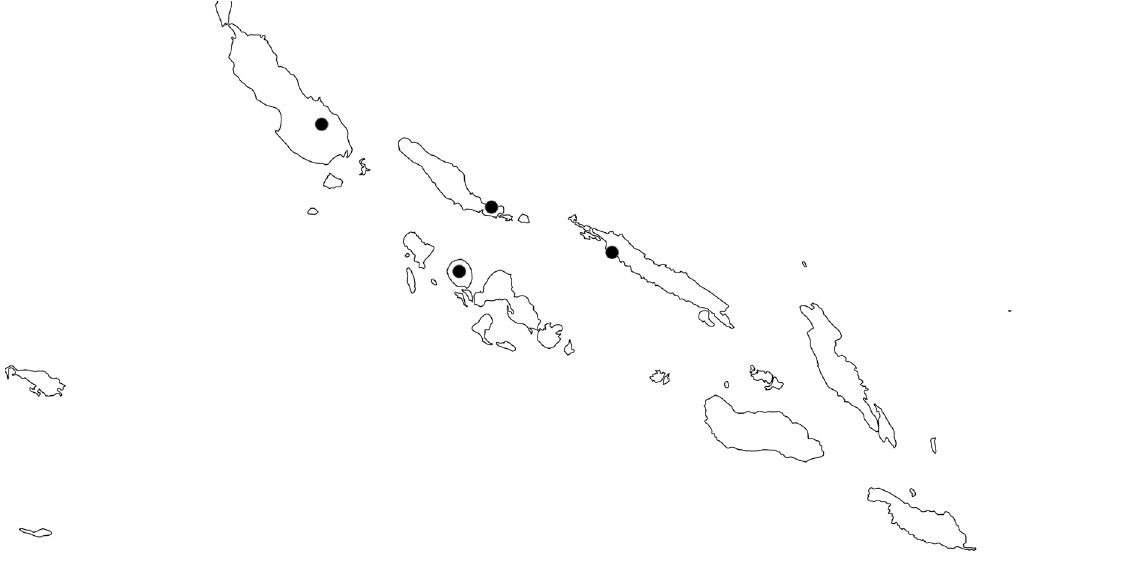
Fig. 4. Map of the Solomon Archipelago showing the collecting localities of Monoon salomonicum I.M.Turner & Utteridge sp.